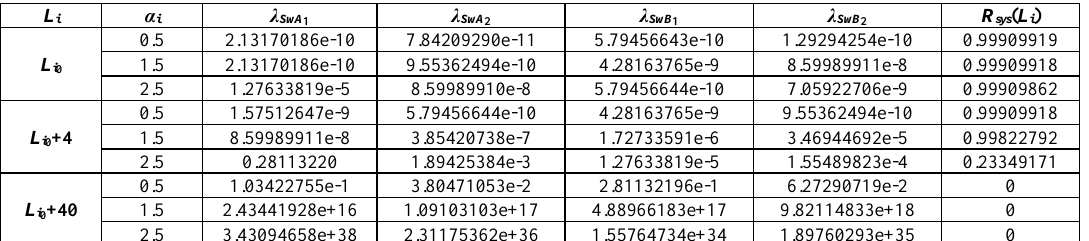
Table 7. Switch failure rate ( λ i ) and SAN reliability ( R sys ) under different loads L i and α i a t t=8640 h. L i α i λ SwA